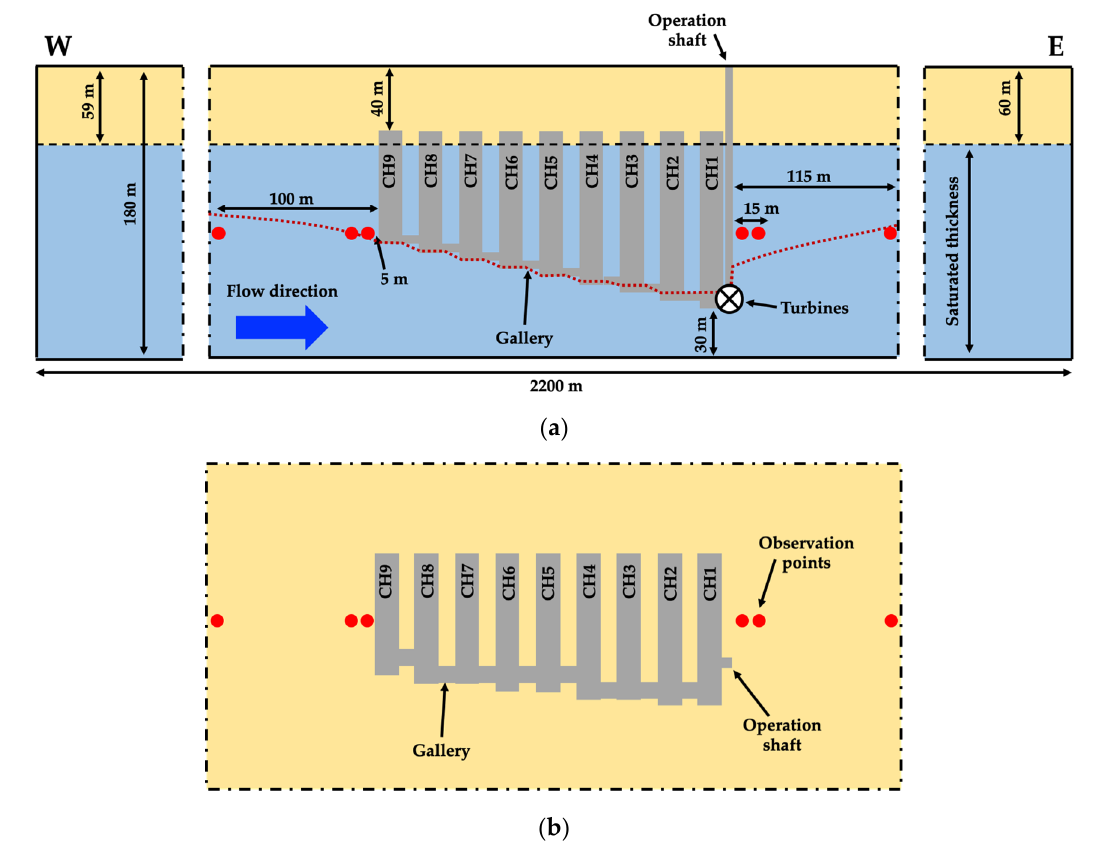
Figure 2. Schematic cross section ( a ) and plan view ( b ) of the study site. In ( a ), the black dashed line indicates the natural position of the piezometric head that agrees with the initial conditions of scenario F-CI and the red dotted line shows the initial piezometric head of scenario E-CI.